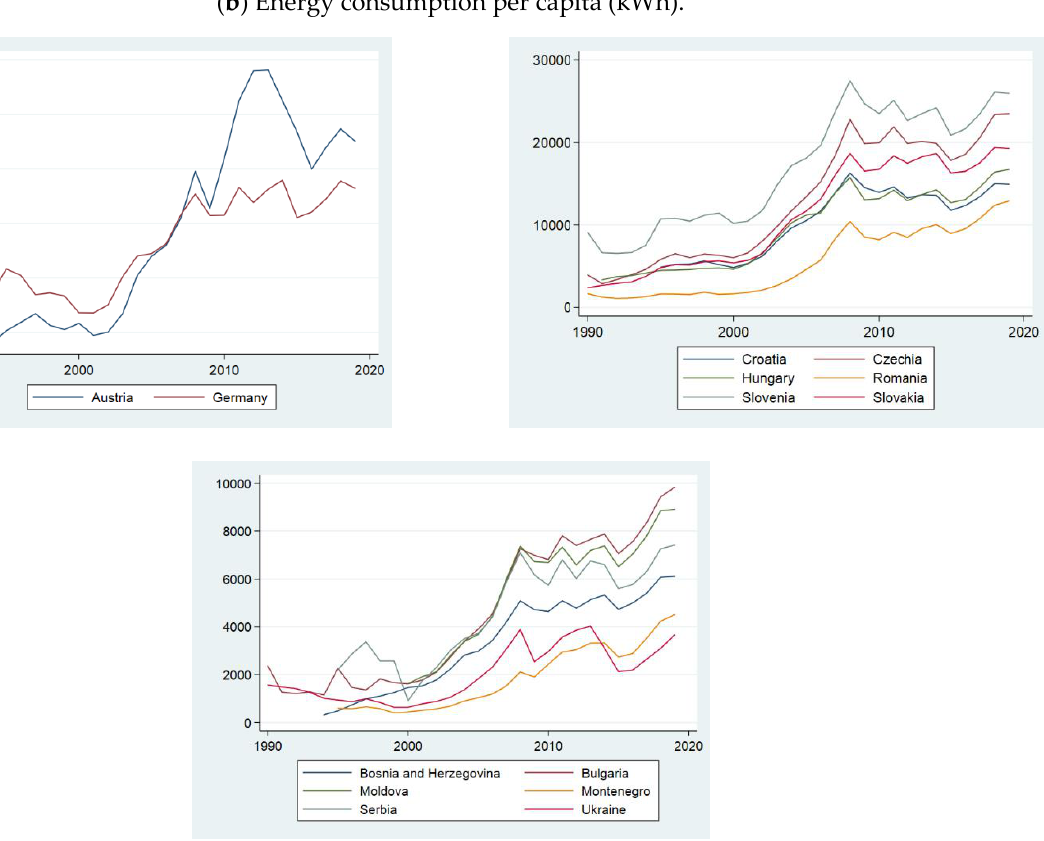
Figure 1. Plot of CO 2 emissions, energy consumption and GDP for Danube region countries. The Czech Republic and Germany were the largest producers of CO 2 emissions per capita in the surveyed group of countries. We recorded the lowest volume of carbon emissions in Moldova (Figure 1a). The Czech Republic, Austria and Germany are leaders in energy consumption per capita. In Moldova, energy consumption per capita was at its lowest level. GDP per capita varies significantly among Danube region countries. Austria and Germany have the highest GDP per capita; on the opposite side of the spectrum are non- EU countries: Ukraine, Moldova, Bosnia and Herzegovina and Serbia. In some countries, we observe significant differences in the development of individual variables, which was reflected in the high value of standard deviation. An example is Austria, where the GDP grew significantly during the period under review, which can be attributed to a highly developed industry and international tourism. The opposite case is Ukraine, where we can observe a significant drop in all monitored variables, which probably corresponds to the country’s poor economic situation associated with the ongoing armed conflict. 3.2. Methodology The theoretical and empirical literature signifies that economic growth, CO 2 emissions and energy consumption are bound together. We work with such data from fourteen countries. In line with Odugbesan and Rjoub [51], economic growth and energy consumption are utilised in natural logarithm form. We use the abbreviations LGDP t , CO 2t and LEC t to denote their values at time t. This research utilises the unit root test of Dickey and Fuller [54], the stationarity test of Kwiatkowski et al. [55] and the bound test for cointegration of Pesaran et al. [56], which